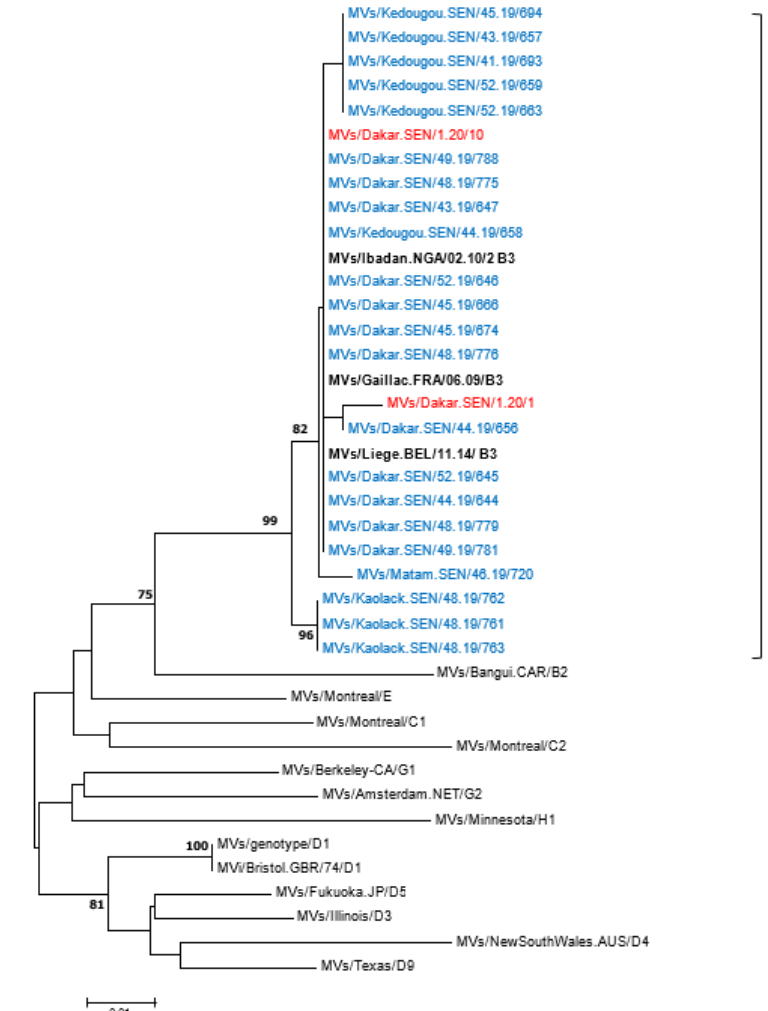
Figure 4. Phylogenetic relationships of measles strains detected in Senegal (2019 and 2020) with WHO reference sequences. The tree was constructed based on the 450 nucleotides coding the C-terminal end of the nucleoprotein gene using the neighbor-joining method under the Kimura 2-parameter model, as implemented in MEGA 7 software. The robustness of the nodes was tested with 1000 bootstrap replications and bootstrap support values greater than 70 are shown at the nodes. Senegalese strains are denoted in blue (2019 sequences) or red (2020 sequences) diamond. Scale bar indicates nuclelotide substitutions per site. Identical strains are not shown.